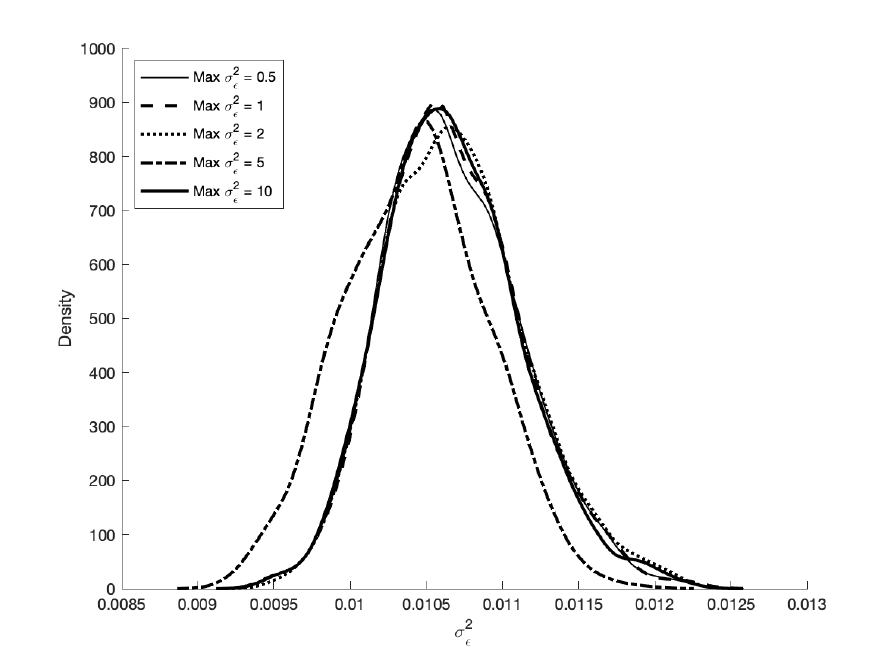
Figure A3. Kernel density estimates of the posterior distribution for σ 2 (cid:101) across prior distribution parameter specifications of Max σ 2 (cid:101) = 0.5,1,2,5, and